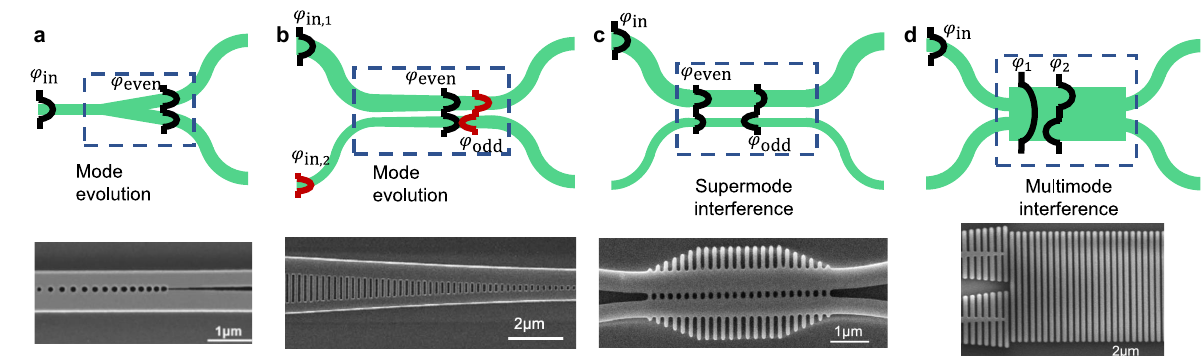
Figure 9: Configurations of conventional beam splitters and scanning electron micrographs of exemplary subwavelength implementations: (a) Y-branch, (b) adiabatic coupler, (c) asymmetric directional coupler, and (d) multimode-interference coupler. These devices exploit sub- wavelength structures to achieve smaller size, better performance, or both. Micrographs in (a), (b), and (c) are reproduced with permission from Refs. [59, 63, 65].